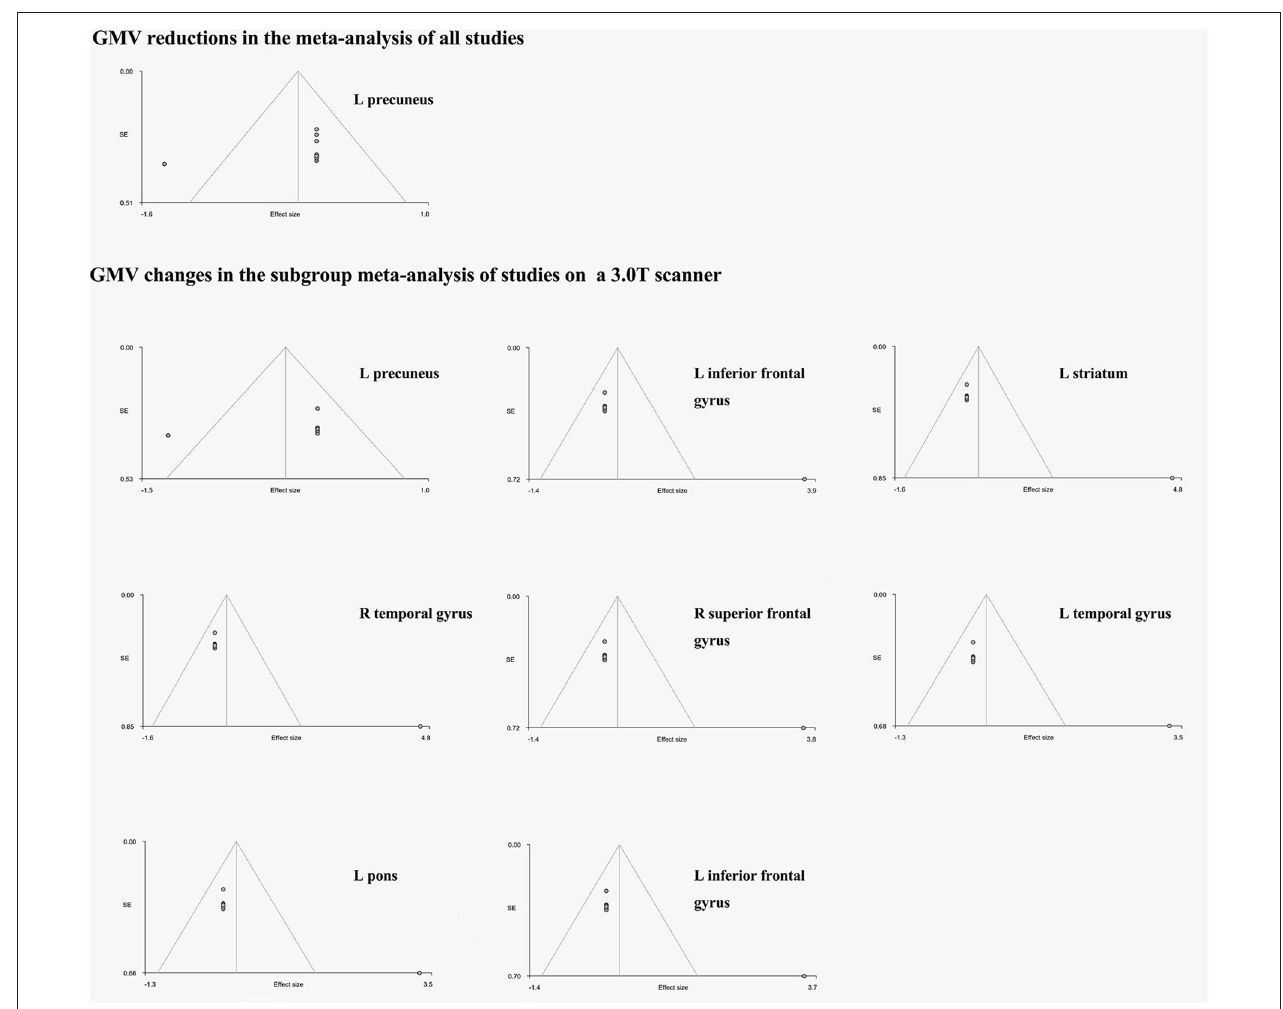
FIGURE 2 | The funnel plots of the significant results of the whole meta-analysis and the subgroup meta-analysis. GMV, gray matter volume; L, left; R, right. The horizontal axis represents effect sizes of the significant peaks; The vertical axis represents the standard